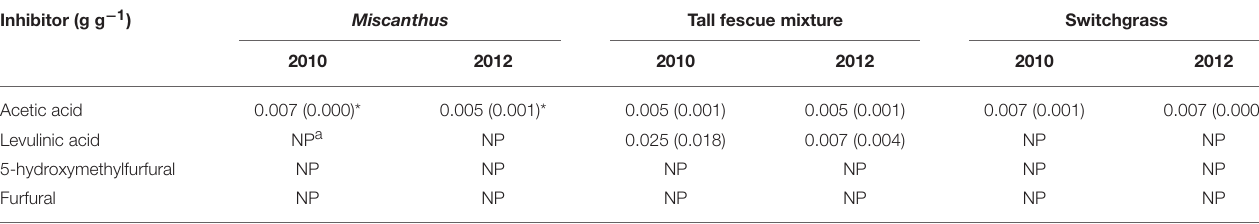
TABLE 6 | Enzymatic hydrolysis and fermentation inhibitors (grams per gram dry biomass) measured in the dilute-acid pretreatment (DAPT) hydrolysates for Miscanthus , the tall fescue mixture, and switchgrass grown in 2010 and 2012 [ n = 3; mean (1 SD )]. Inhibitor (g g − 1